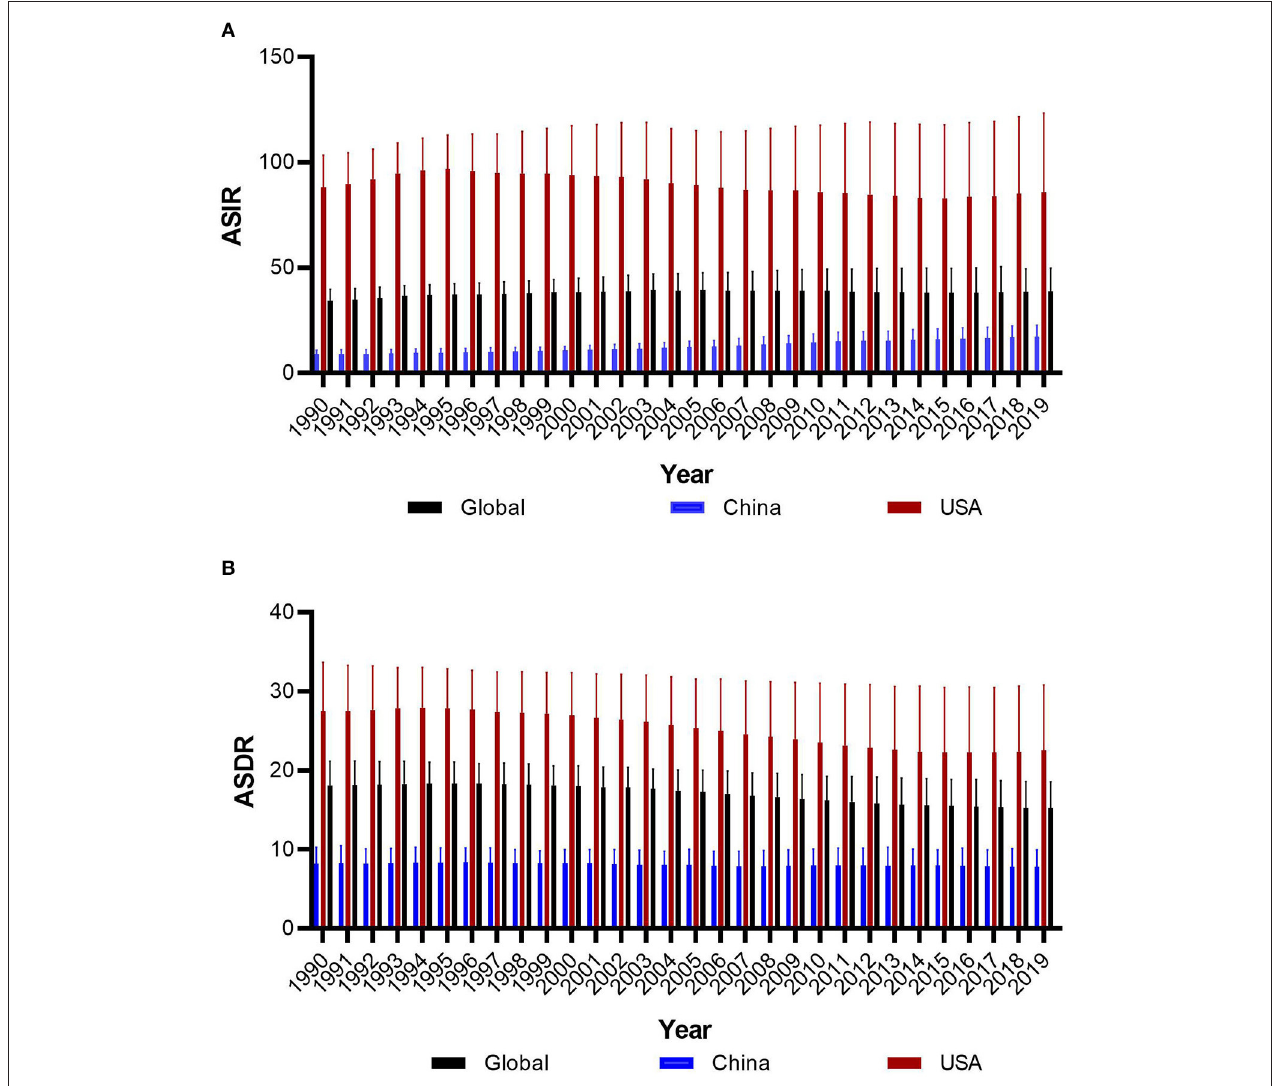
FIGURE 1 | The trends of age-standard incidence rate (A) and death rate (B) of prostate cancer in global, China and America from 1990 to